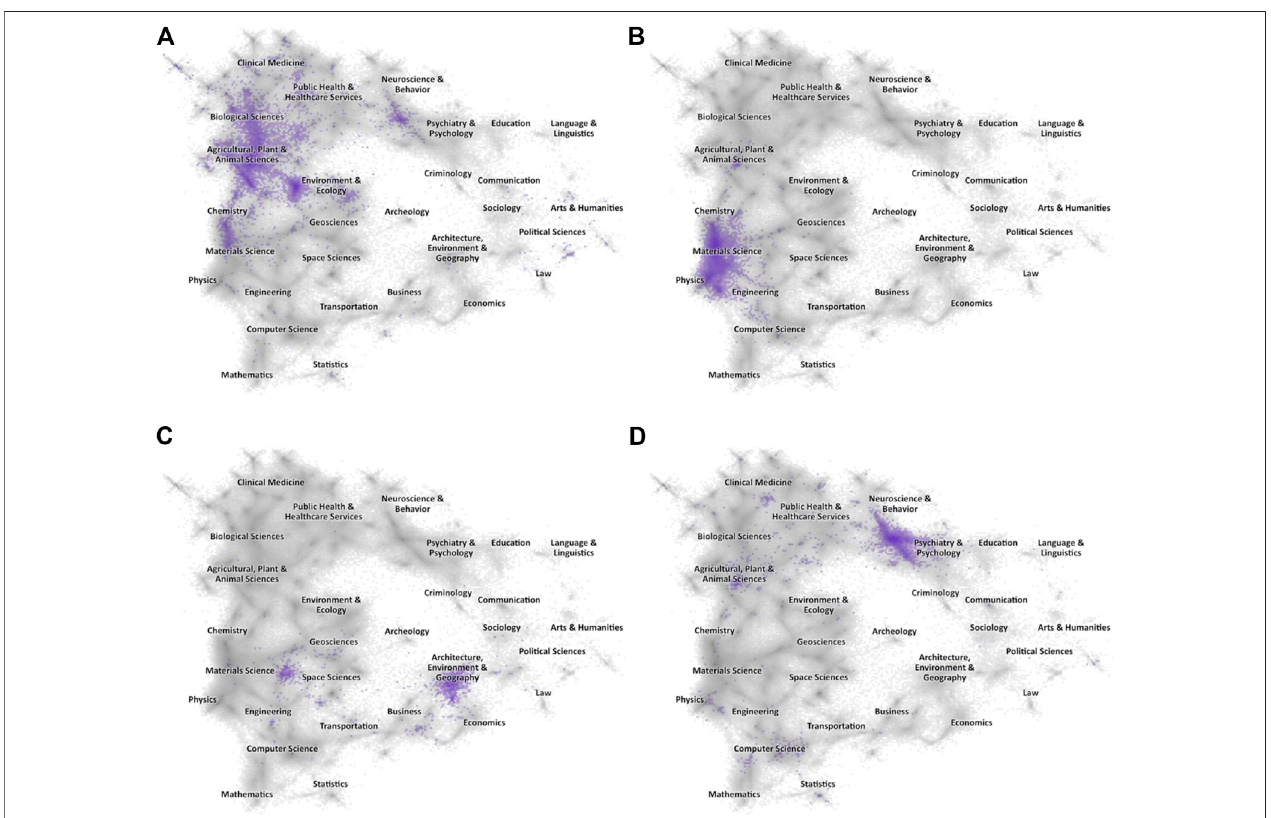
Figure9|(A) – (D) .SciencemapsshowingthespreadofarticlesinfourtopicalResearchFronts.Thegreyedlandscapeistheproximitymapforallarticlesindexedin the Web of Science (2010 – 19) within which major domains have been labeled, and the highlighted area in each map are those papers linked to a speci fi c